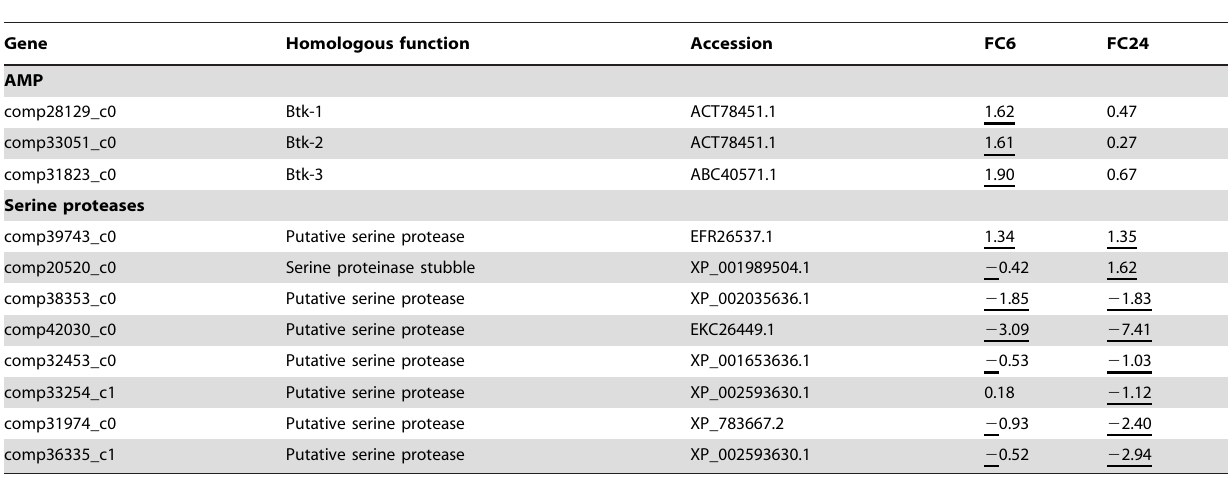
Table 2. Genes involved in humoral